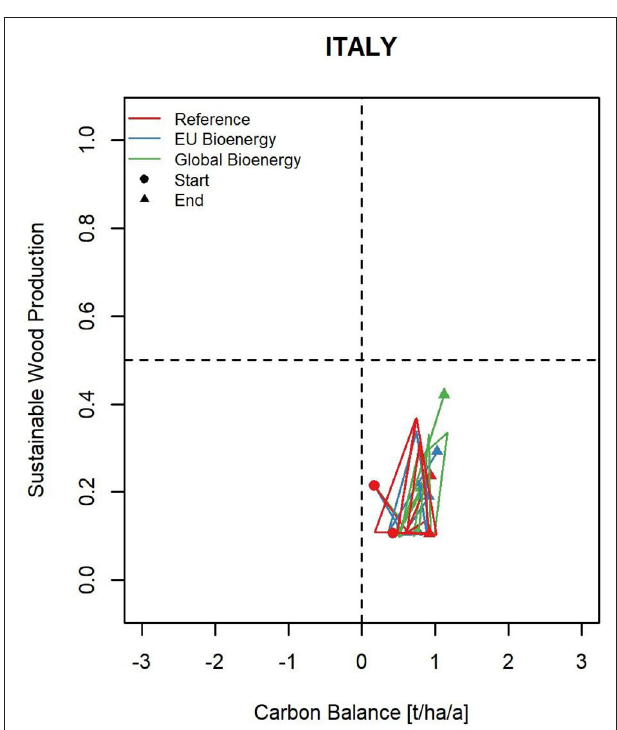
FIGURE 8 | Trade-off diagram for Italy. For the Italian case study, no data were available for the assessment of biodiversity based on this study’s approach. Thus, only the trajectories for sustainable wood production and the carbon balance can be